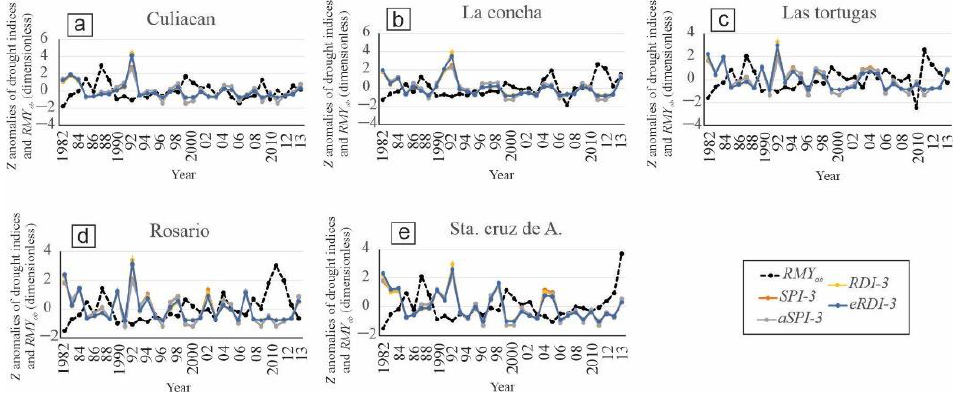
Figure 3. Z anomalies of the drought indices SPI-3 , aSPI-3 , RDI-3 and eRDI-3 , and RMY ob (dimen- sionless). The black line refers to RMY ob and the four meteorological drought indices in Sinaloa are shown in red ( SPI-3 ), gray ( aSPI-3 ), yellow ( RDI-3 ) and blue ( eRDI-3 ) ( a – e